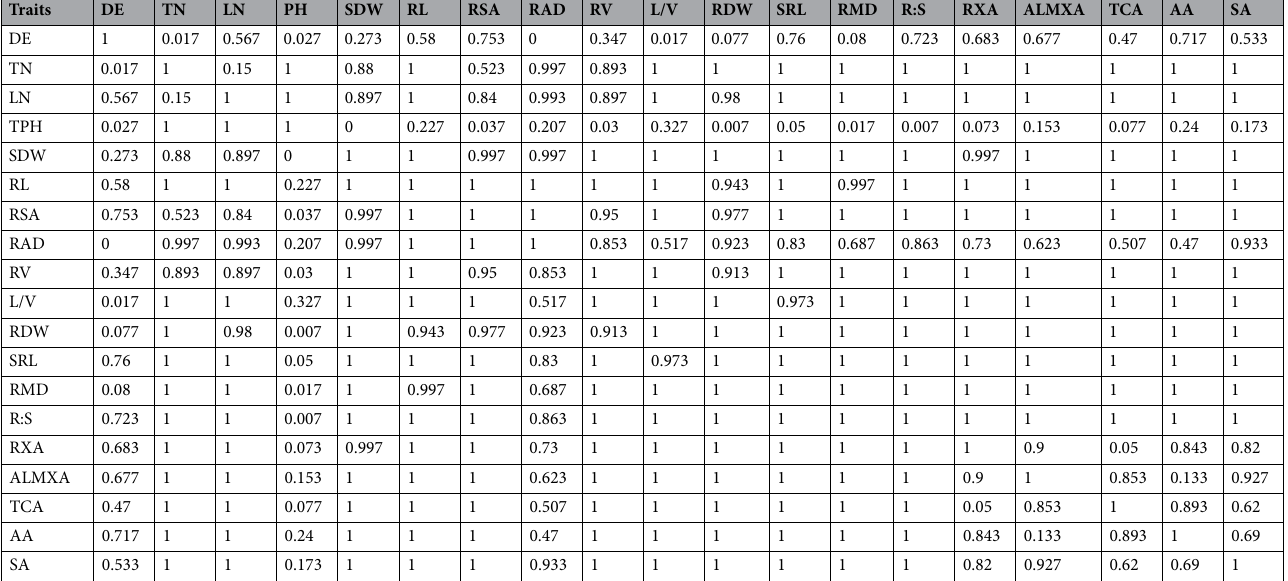
Table 3. Summary of allometric analysis of root-shoot system traits under hydroponic condition. The P -values of allometric cross comparison of root morphological, anatomical and shoot traits. P -value < 0.05 indicate a significant allometric relation between the traits calculated by bootstrapping (boot = 300). See Table 1 for traits description.